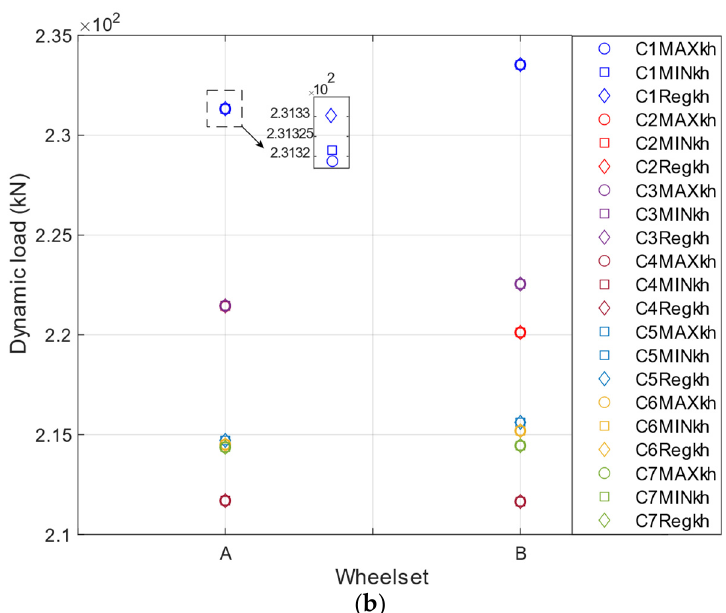
Figure 5. Dynamic load for different values of contact stiffness: ( a ) Alfa Pendular; ( b ) freight wagon.